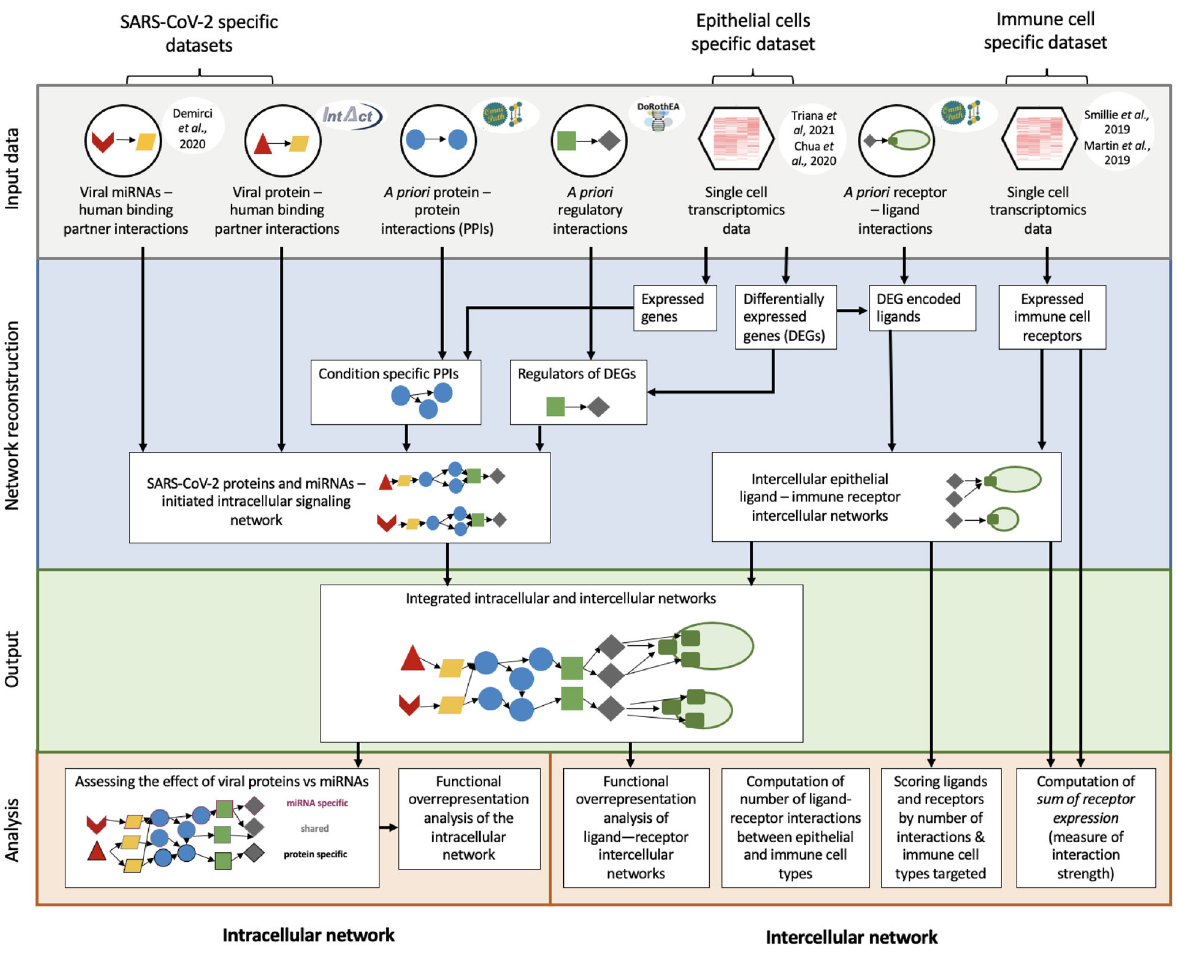
Fig. 1 Integrated work fl ow to analyse the intracellular and intercellular effect of SARS-CoV-2 in the gut. Schematic work fl ow illustrating the different analytical steps used to construct the intracellular and intercellular signalling networks between epithelial cells in SARS-CoV-2 infected intestinal organoids (ileal and colonic organoids, 24 h infection) or moderate COVID-19 upper airway ciliated epithelial and immune cell